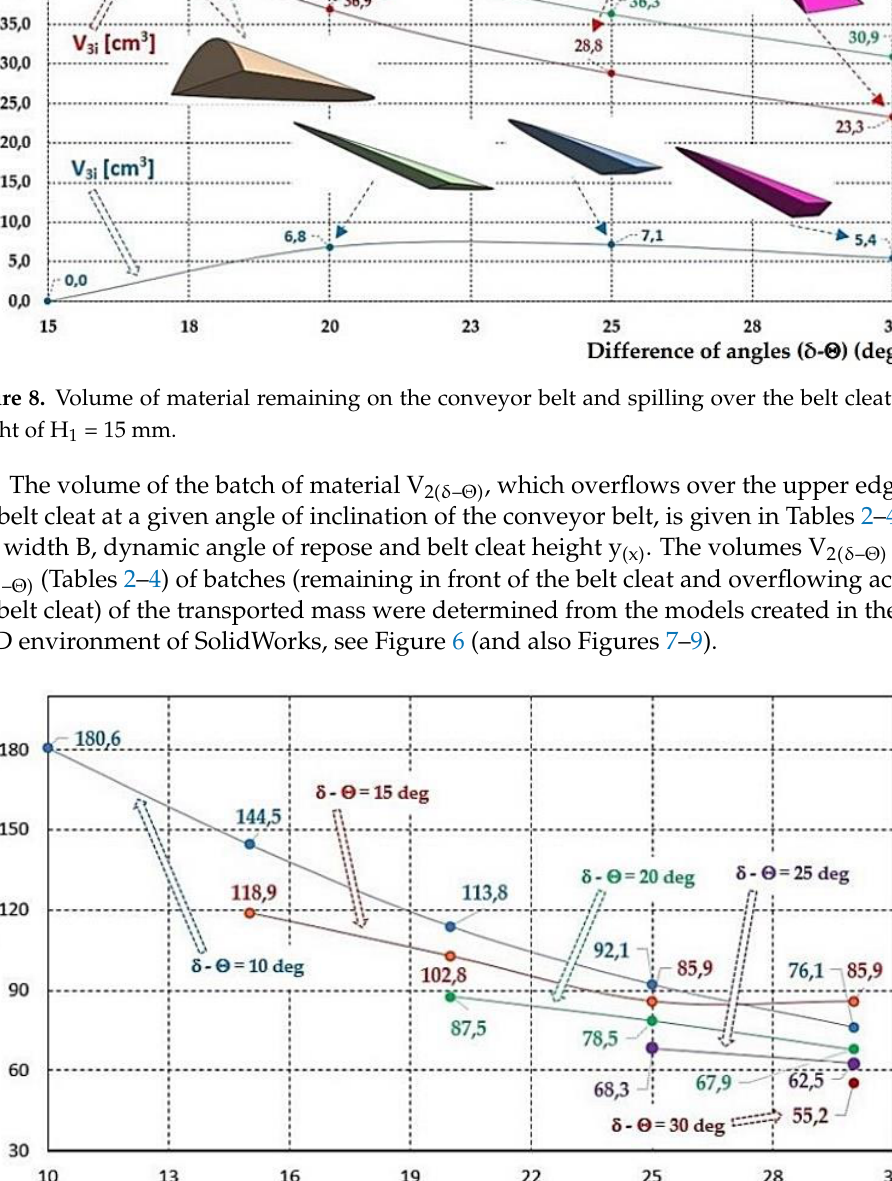
Figure 10. Batch volume V 2( δ–Θ ) of material spilling over a belt cleat of a height H 1 = 20 mm. 3.2. Experimentally Determined Distribution of Material and Its Volumes A batch of material of volume V 1(10) was applied to the upper surface of the trough I of the test equipment (Figure 3) inclined by an angle (see Tables 2 – 4). The slope of the trough was then increased, always by increments of 5 deg, and the values (for three suc- cessive measurements) of the distance of material distribution on the trough surface and the volume of material that spilled over the belt cleat were recorded in Tables 5 – 6, as de- termined by subtraction in the measuring cylinder.